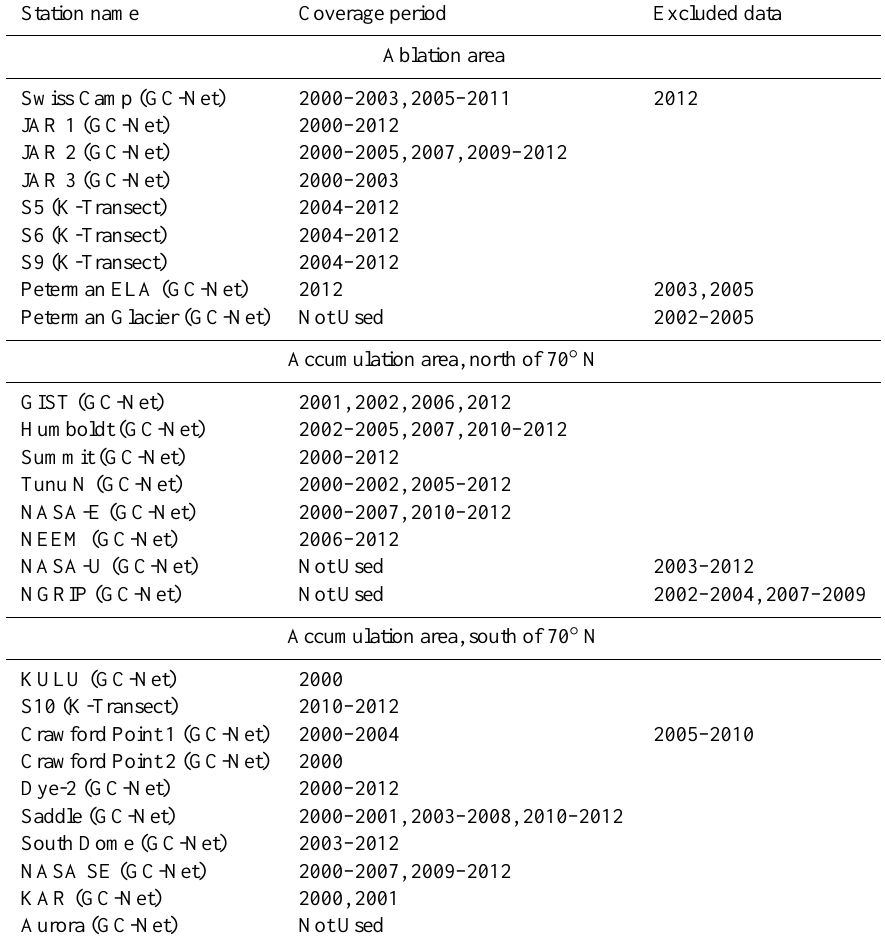
Table 2. GC-Net and K-Transect weather stations used in this study and years of